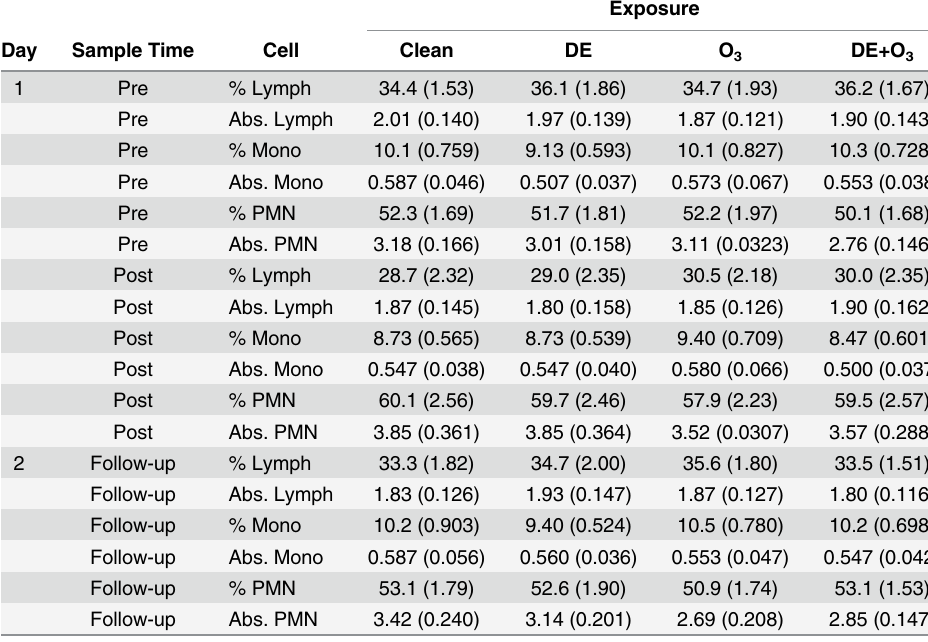
Table 3. Cell count descriptive statistics by exposure and sample time. a